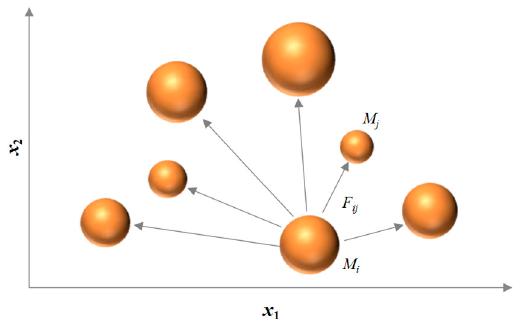
Figure 1. Sketch map of the gravitational search algorithm (GSA) method for a two-variable problem.